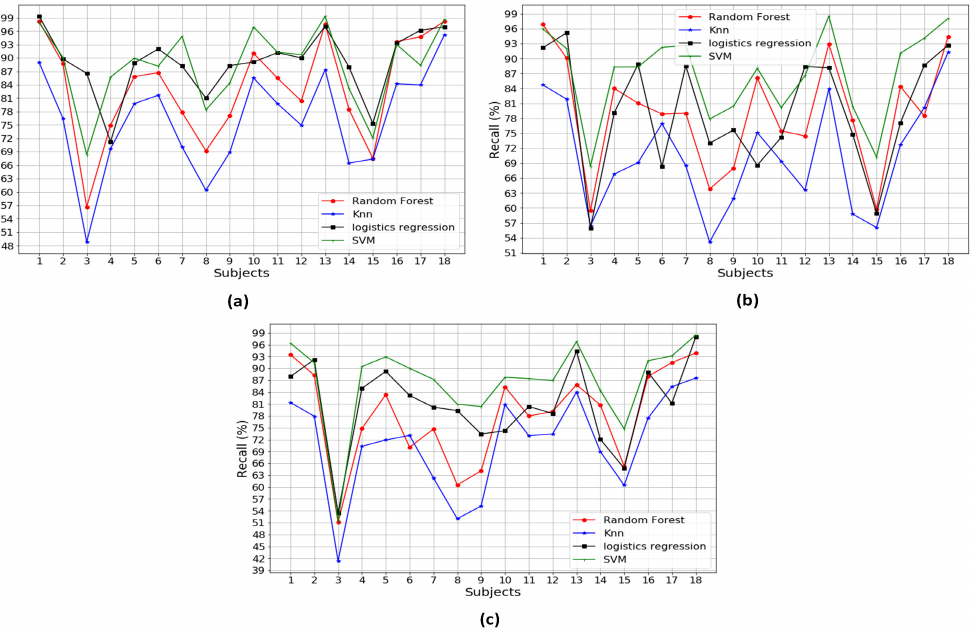
Figure A4. The average recall performance over a combination of two types of sensors: ( a ) recall over Pre+Acc; ( b ) recall over Pre+Gyro; and ( c ) recall over